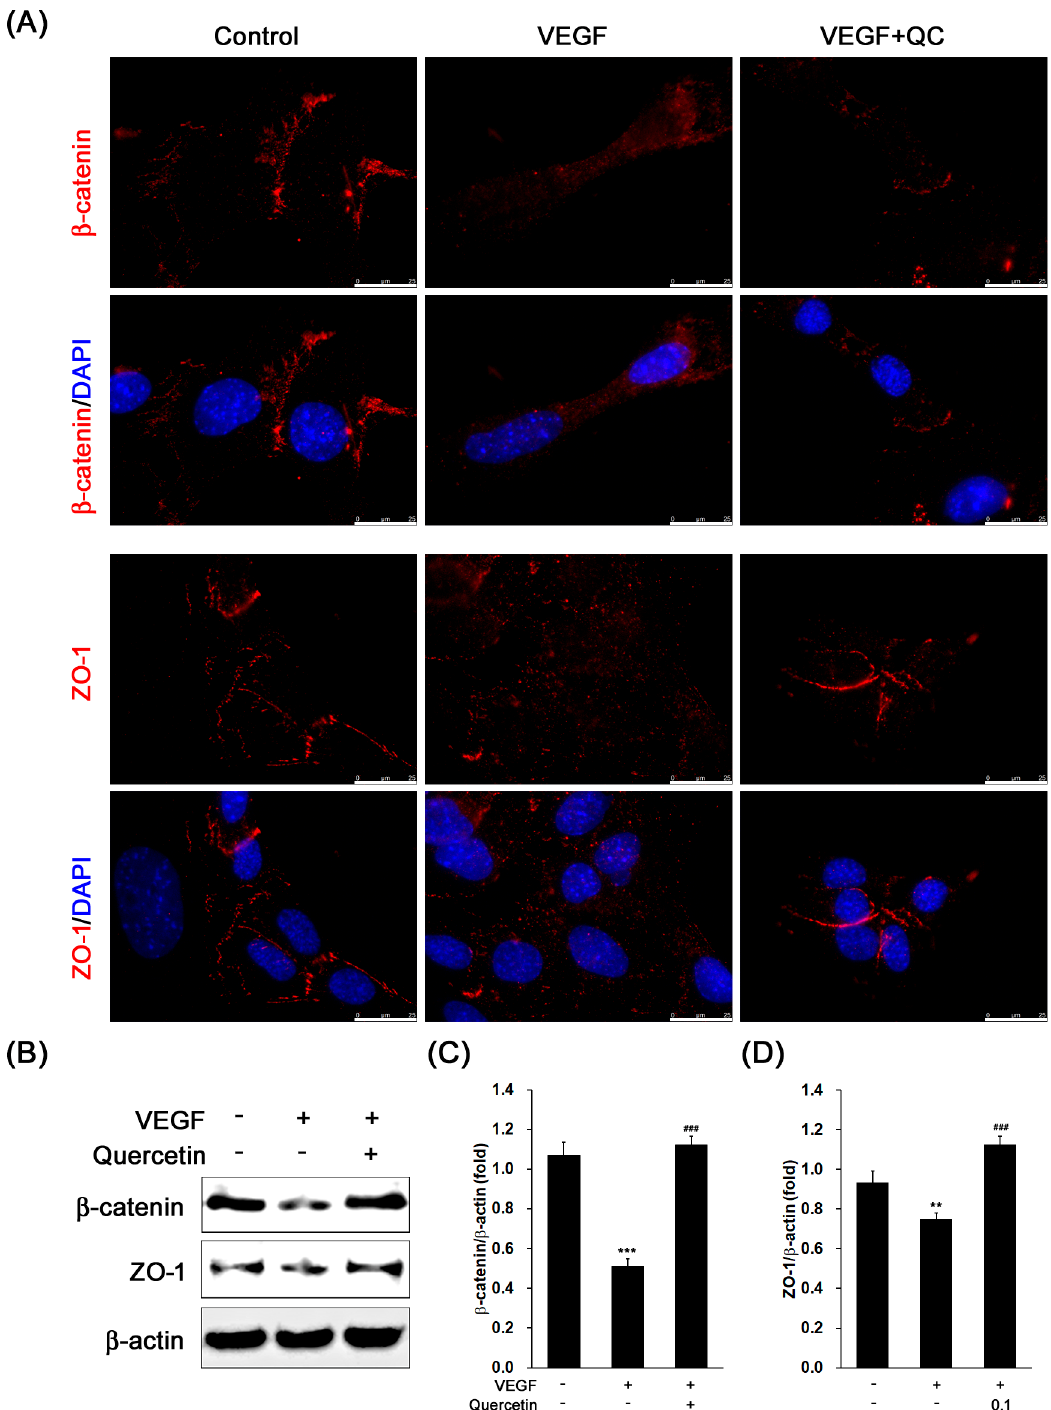
Figure 5. Effect of quercetin on the expression of tight junction proteins in VEGF-stimulated 661W cells. Cells were treated with VEGF (20 ng/mL) in the absence or presence of quercetin (0.1 µM) for 16 h. ( A ) The immunostained cells with β -catenin or ZO-1 were prepared for fluorescence microscopy analysis. Scale bar means 25 µm. ( B ) The protein expression was detected by immunoblot. ( C , D ) Densitometry quantifications of β -catenin ( C ) and ZO-1 ( D ) protein expression were measured by ImageJ. Data are the means ± SDs of three independent experiments. ** p < 0.01 and *** p < 0.001 indicate significant differences compared to the non-treated control group. ### p < 0.001 indicates significant difference compared to the VEGF-only treated group (scale bar means 25 µm).